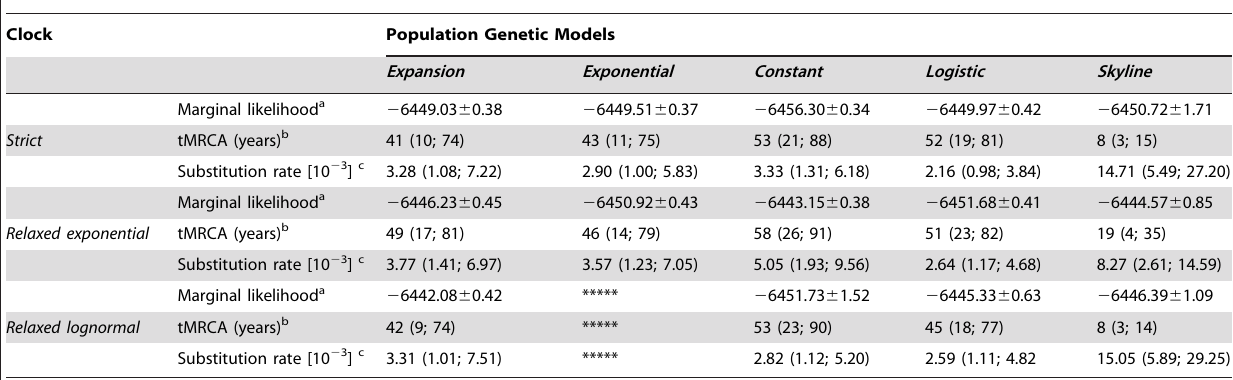
Table 4. Estimates of the substitution rate and the tMRCA of HCV for the E2 gene without HVR1 by Bayesian coalescent methods under several molecular clock and population genetic